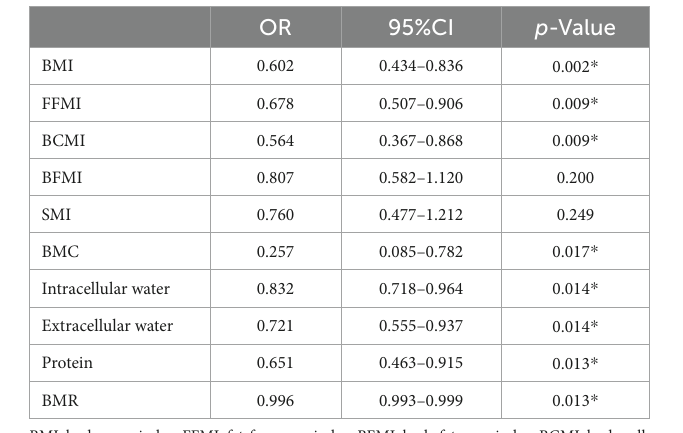
TABLE 4 Univariate analysis of body composition associated with nutritional risk.